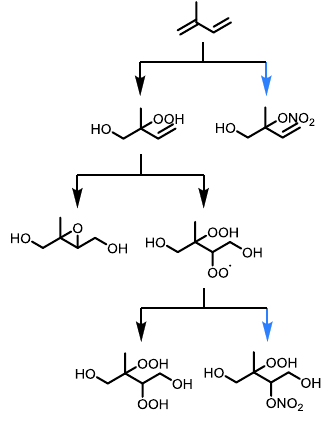
1022 1023 Scheme 1. A simplified schematic of isoprene and its major oxidation products. Products formed 1024 Scheme 1. A simplified schematic of isoprene and its major oxida- in the presence of NO x are identified with blue arrows. 1025 tion products. Products formed in the presence of NO x are identified 1026 with blue